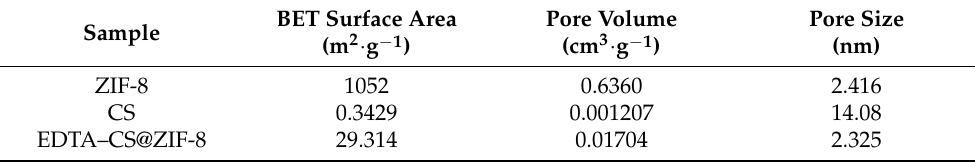
Table 1. Brunauer–Emmet–Teller (BET) surface area, pore size, and pore volume of ZIF-8, CS, and